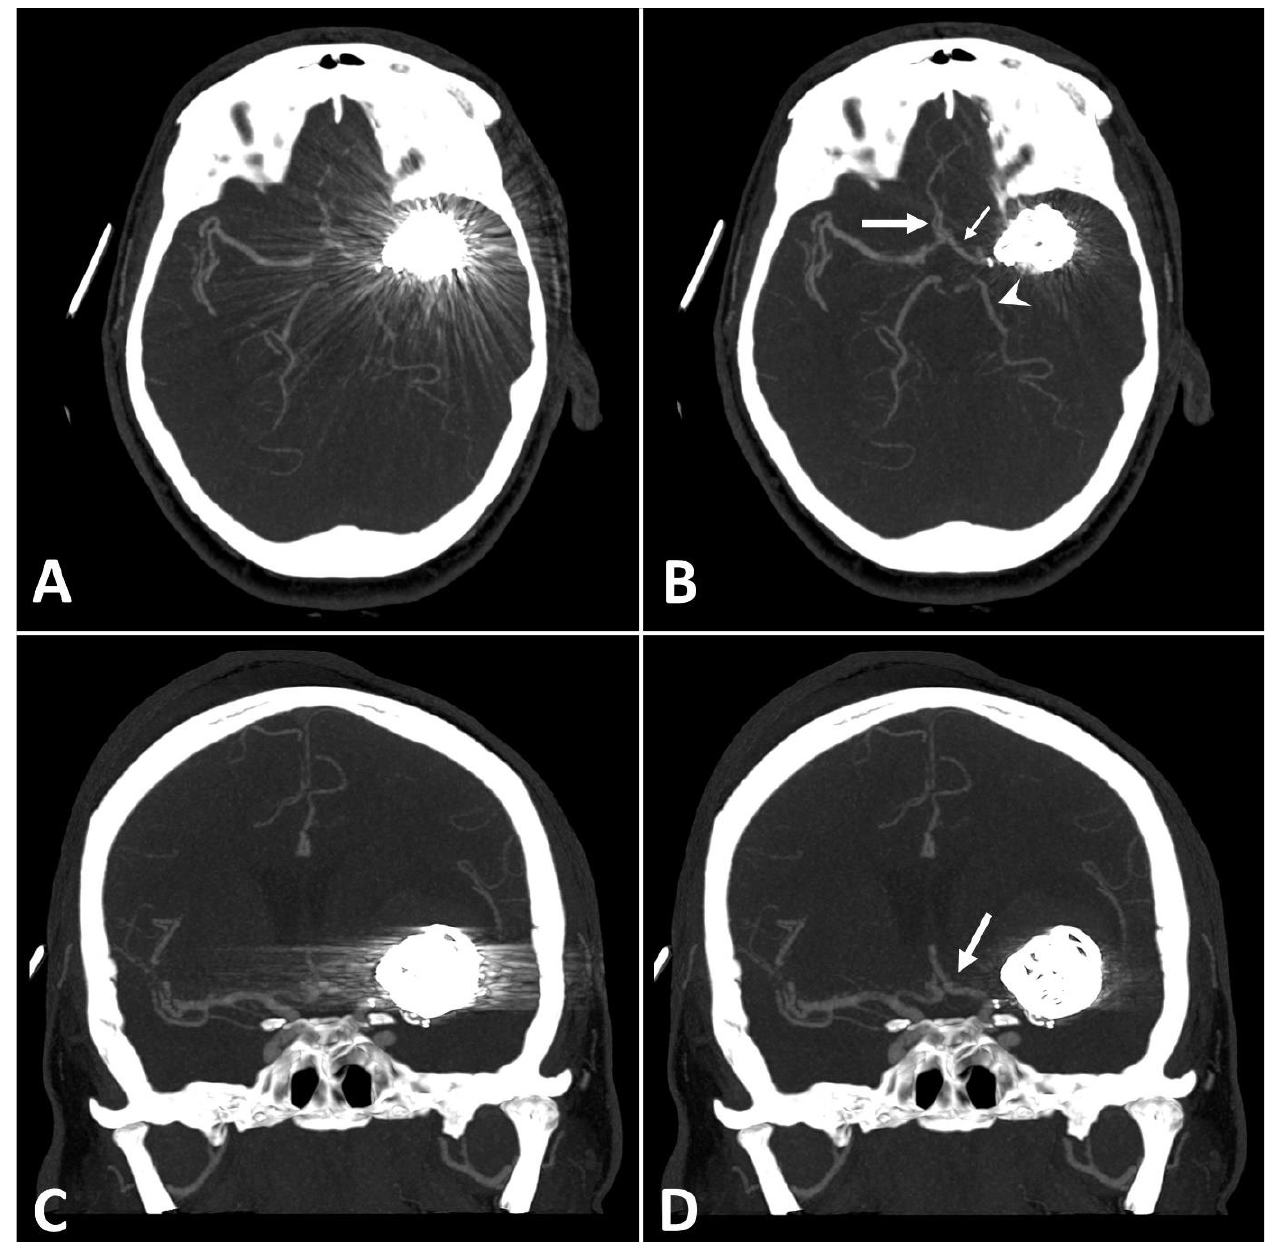
Figure 3. Exemplary follow up UHR-CT-angiography in axial and coronal plane without ( A , C ) and with SEMAR ( B , D ) of a 48-year-old female after intracranial coil-embolization of a left sided middle cerebral artery aneurysm, demonstrate the efficacy of SEMAR in visualizing vessels adjacent to the coil package like the ipsilateral middle cerebral artery (thick arrow in ( B )), the anterior cerebral artery (thin arrow in ( B )), the ipsilateral posterior cerebral artery (arrowhead in ( B )), and the middle cerebral artery (thick arrow in ( D )). All images were reconstructed as MIP (Maximum Intensity Projection) with 12.5 mm slice thickness.